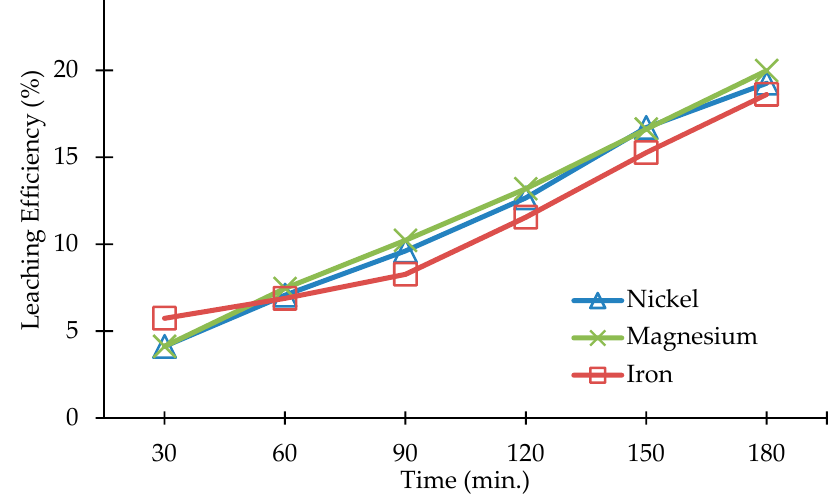
◦ C, 1 M HCl and 300